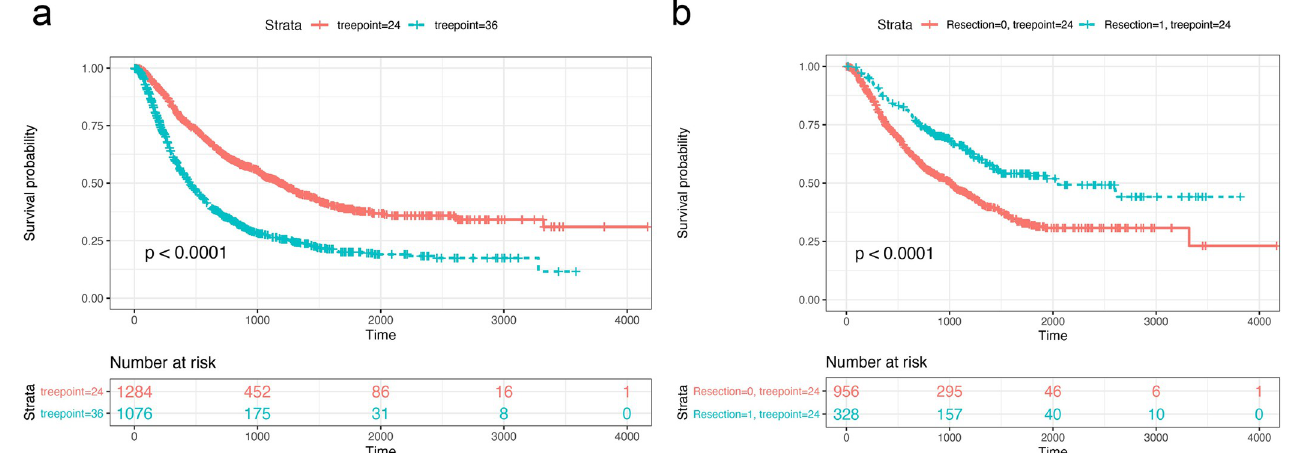
Fig 4. Demonstration of survival curves in comparing survival between different nodes (a) and subgroups with different treatment arms at specific nodes (b).